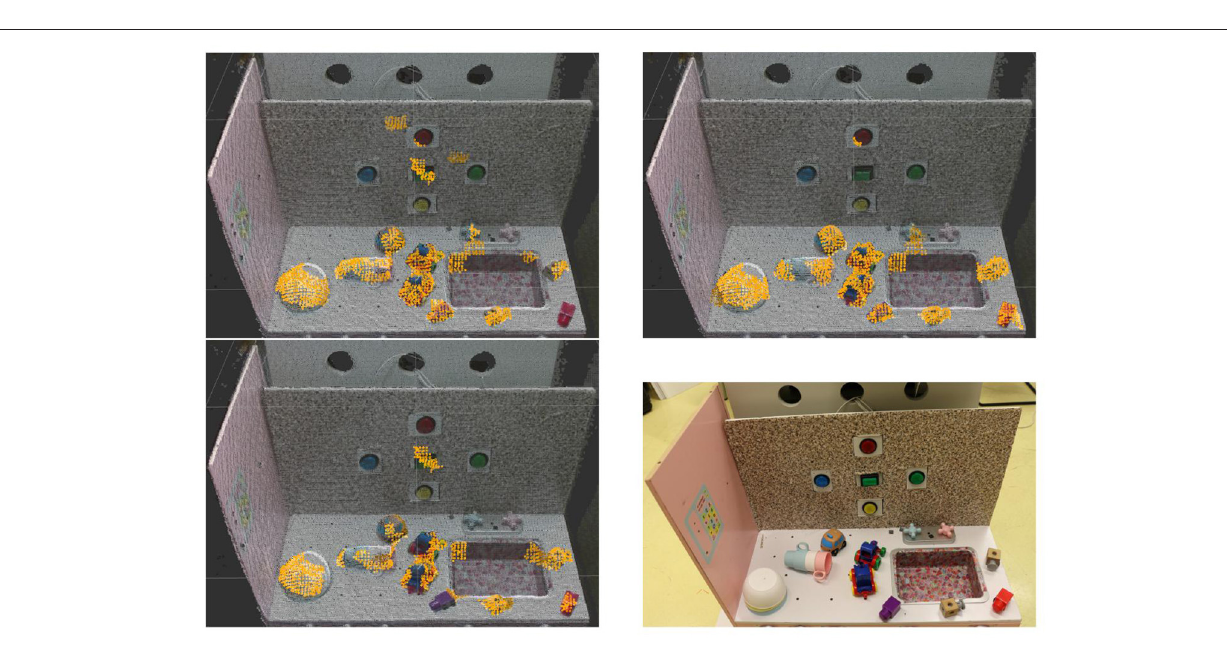
FIGURE 10 | Three push relevance maps extracted from the same scene and with the same classifier on a video stream. The differences between the three maps is due to the extraction of the supervoxels which produces a different segmentation at each frame. The bottom right picture represents the environment from which the relevance maps have been